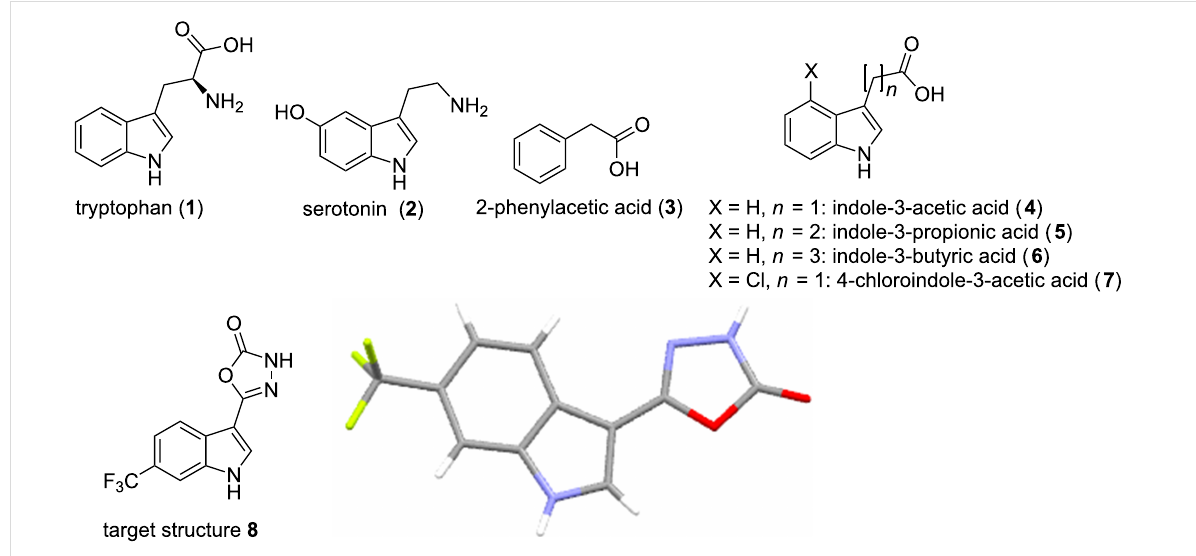
Figure 1: Natural indole containing molecules 1 – 7 of biological importance and synthetic auxin analogue 8 required at scale and X-ray structure.